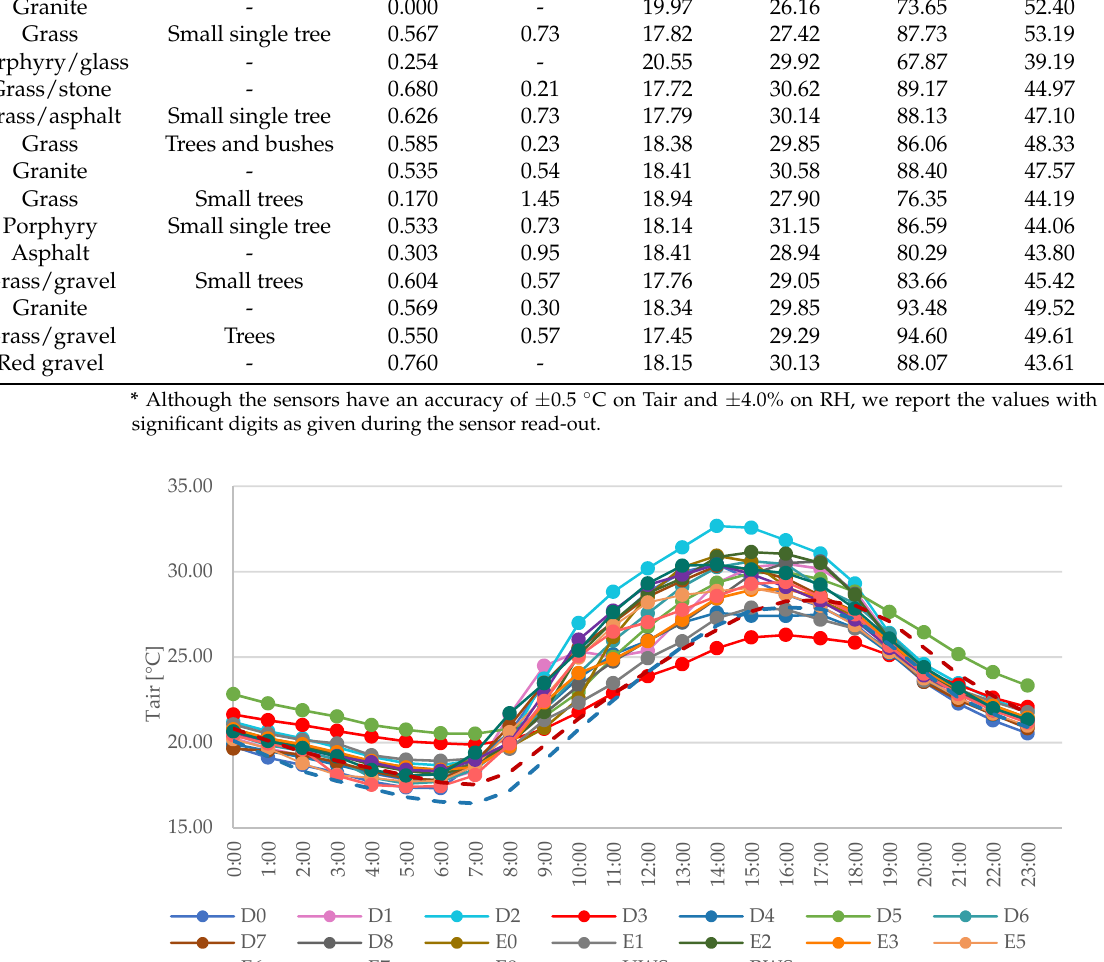
Table 1. Morphological characteristics and hourly averaged air temperature and relative humidity values measured by the sensor nodes in coldest (i.e., 06:00) and hottest (i.e., 15:00) conditions from